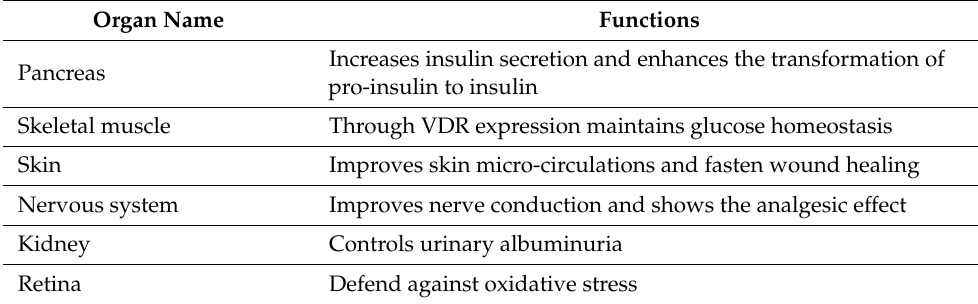
Table 3. Functions of vitamin D on different organs